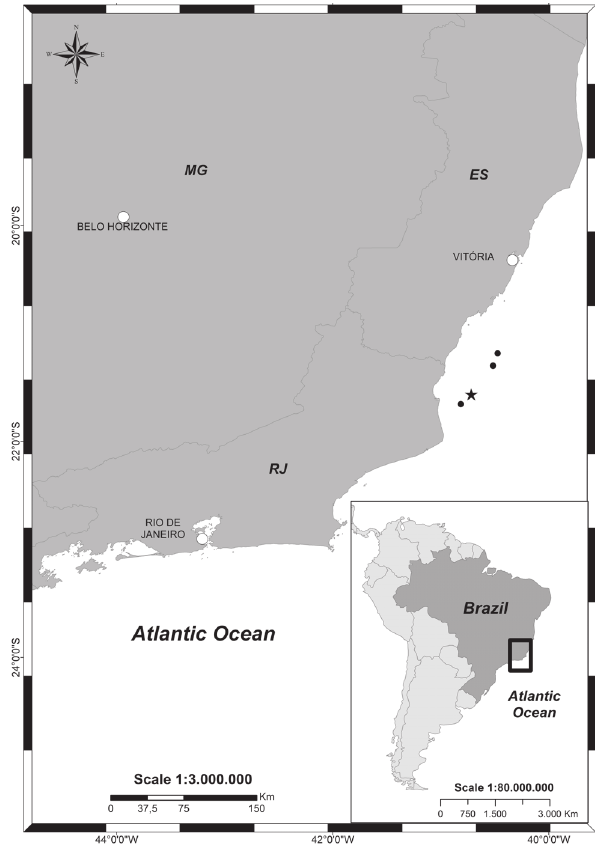
Figure 26. Distribution of Metharpinia taylorae sp. nov. Star: